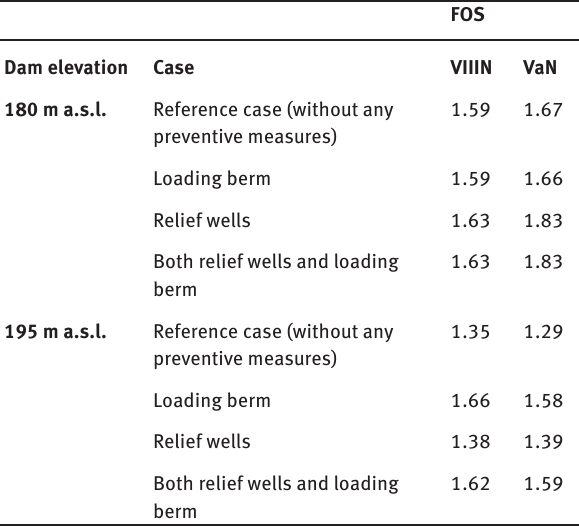
Table 3: Factors of safety for analyzed